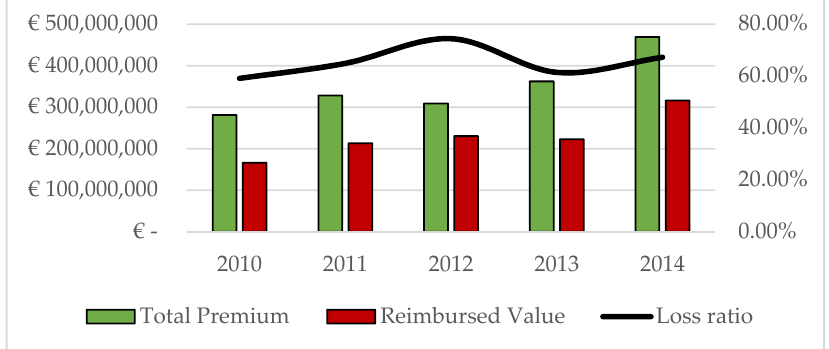
Figure 1. The evolution of the insurance system in Italy 2010–2014. Source: Personal elaboration on SICURAGRO data [51].